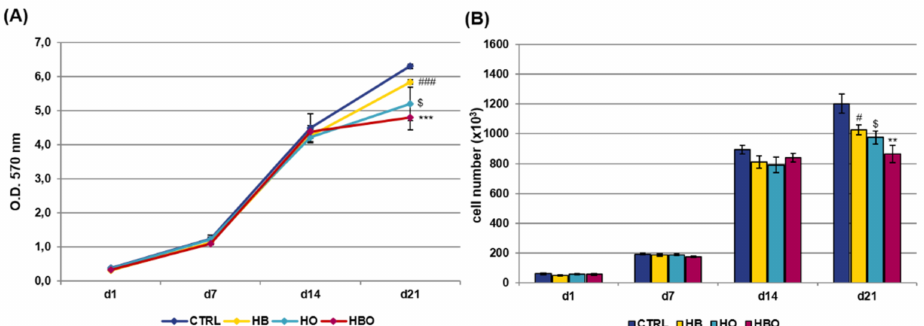
Figure 2. Metabolic activity and proliferation of hADSCs after HBO treatment in the presence of inflammation. ( A ) MTT assay and ( B ) quantification of DNA content in hADSCs 1, 7, 14, and 21 days after osteogenic di ff erentiation in the presence of 10 ng / mL Tumor Necrosis factor- α (TNF- α ) and HBO, HB, or HO treatment. Data are shown as mean ± SD. In both graphs, # and $ p < 0.05 indicate statistically significant di ff erence between the HB- or HO-treated cells and control. ** p < 0.01 and *** p < 0.001 indicate statistically significant di ff erence between the HBO-treated cells and the control group; ### p < 0.001 indicates statistically significant di ff erence between the HB-treated cells and the control